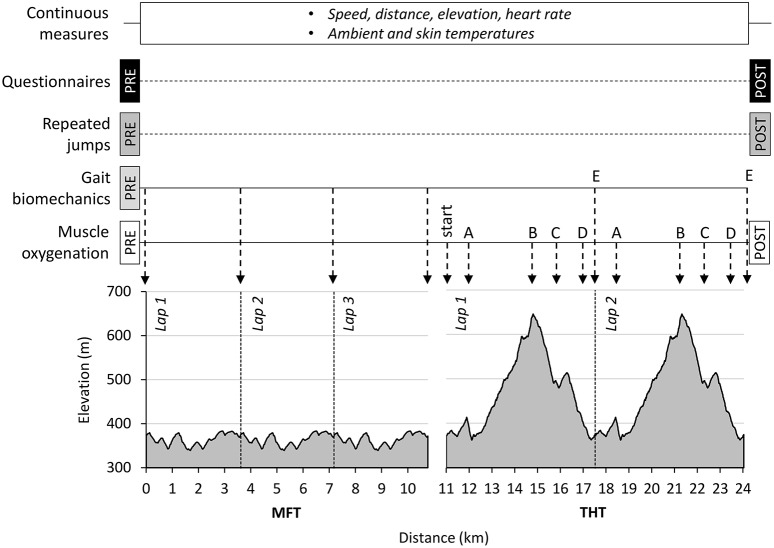
Experimental protocol. Schematic representation of the protocol, measures performed, and elevation gain and loss as a function of distance in the running exercise.